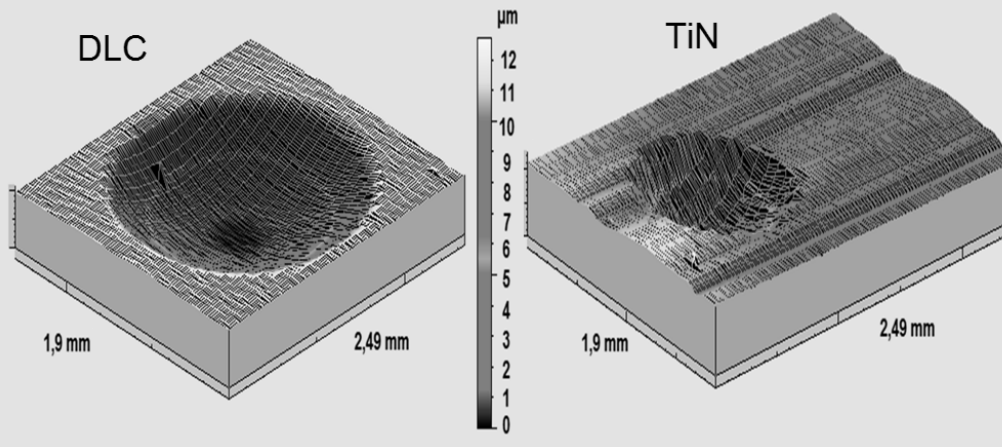
compared with the coefficient of friction (0.3) of DLC.